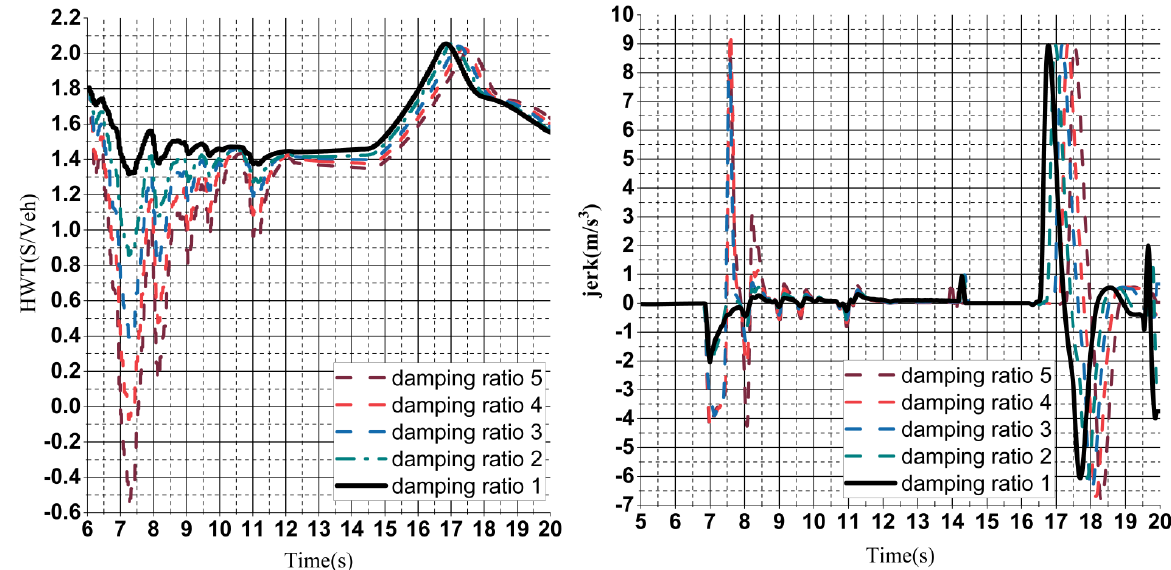
Figure 7. Working condition: team train speed of 14 km/h; cut-in vehicle speed of 10 km/h.